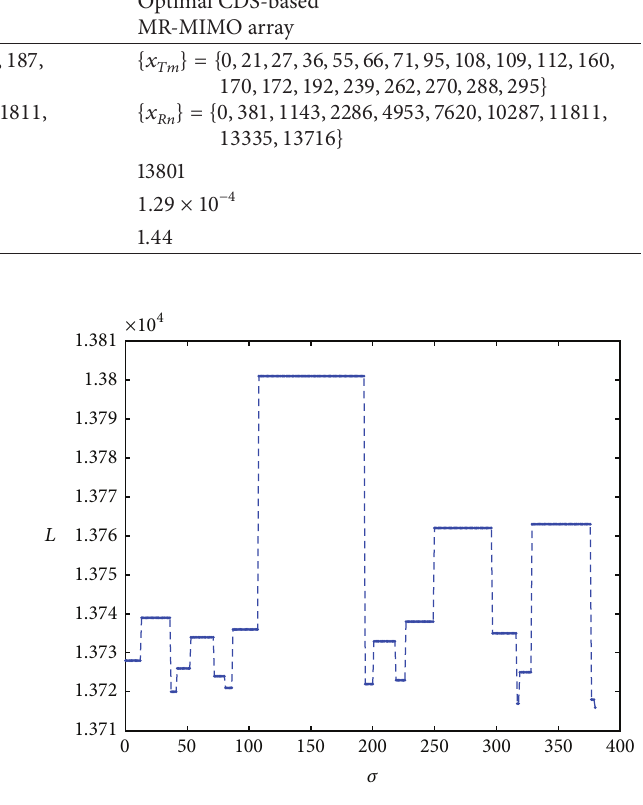
Figure 4: CDS-based enumerative shifting procedure: behavior of virtual array aperture 𝐿 versus evaluated shift 𝜎 for CDS-based MR- MIMO array ( 𝑀 = 20 , 𝑁 = 10